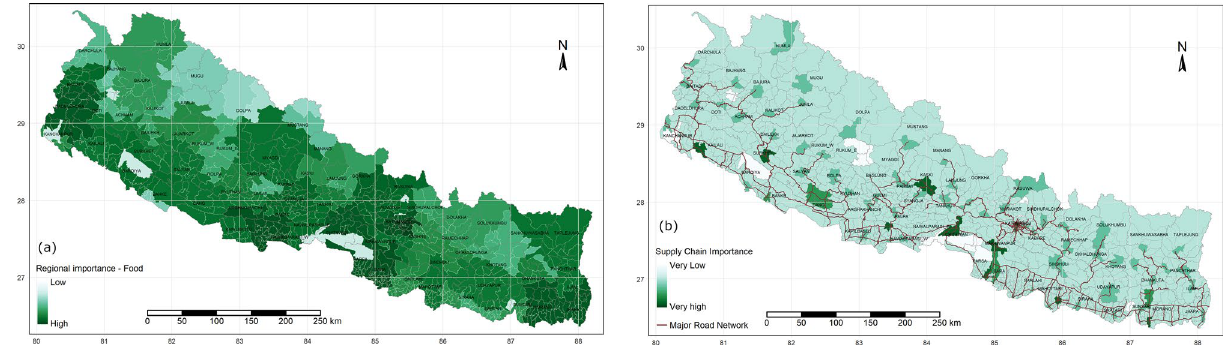
Figure 5. Regional importance food production ( a ) and supply-chain importance ( b ); maps were produced from R programming version 3.5.3; source: https ://cran.r-proje ct.org/bin/windo ws/base/old/3.5.3/.